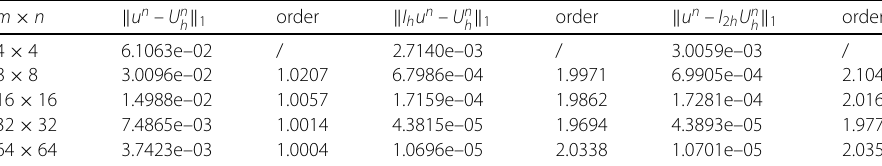
Table 3 Numerical results of u at t = 0.5